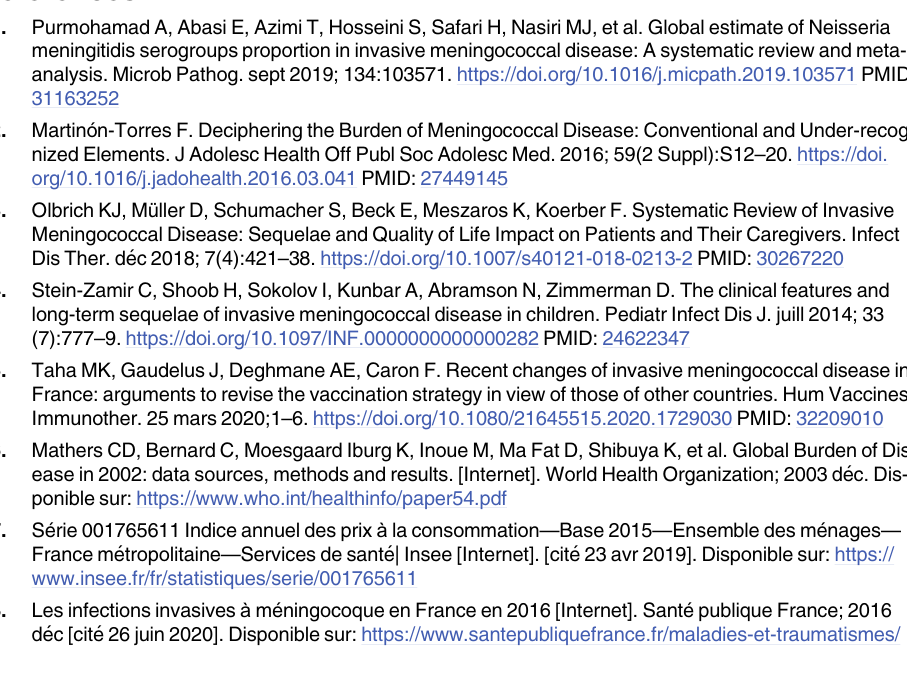
S1 Table. ICD-10 codes used to identify the study population. S2 Table. ICD-10 codes used to identify IMD-related